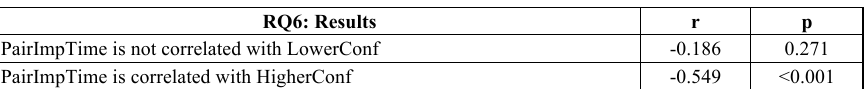
Table 11. Results summary of RQ6 (extended)